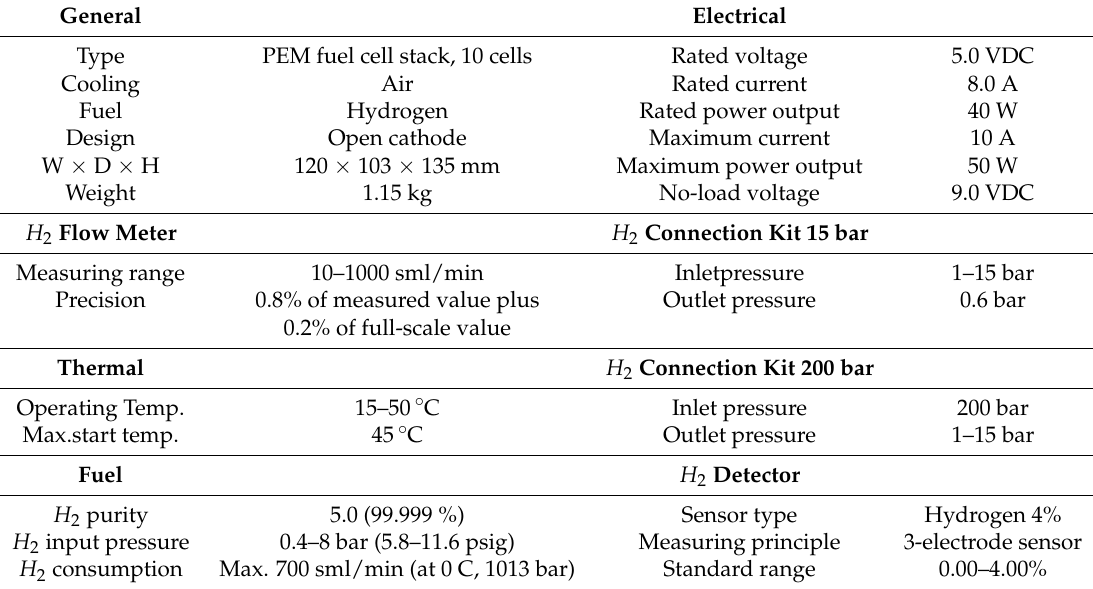
Table 1. Fuel cell stack technical